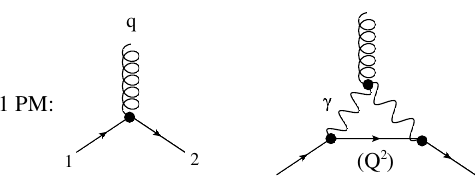
Figure 1 . Contributions to the 1 PM stress tensor form factor. The purely gravitational contribu- tion is given by the tree-level gravitational minimal coupling, while the photon couplings contribute through one-loop effects. Since the charge appears as Q 2 G , the one-loop diagram is still 1 PM. In the presence of extra massless fields, the stress-energy tensor will be modified at 1 PM. These modifications come in as one-loop corrections to the stress tensor form factor, as shown in figure 1, reflecting the fact that the object is charged under the additional massless fields. Note that while this is a loop effect, it retains a classical piece. This